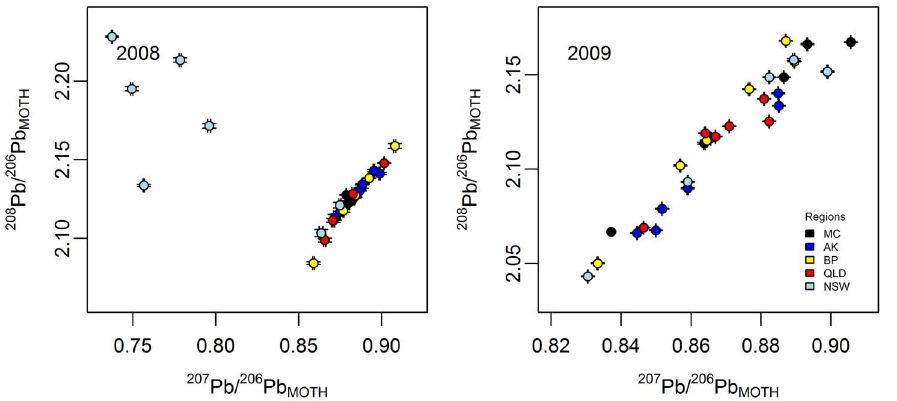
Figure 5. Pb isotope scatter plots from H.armigera . Error bars = analytical 2SD. Note: the axes for the 2008 dataset is larger scale than 2009.